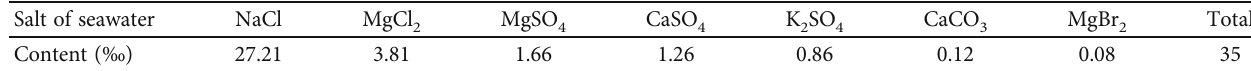
Table 1: The main salt content of seawater.